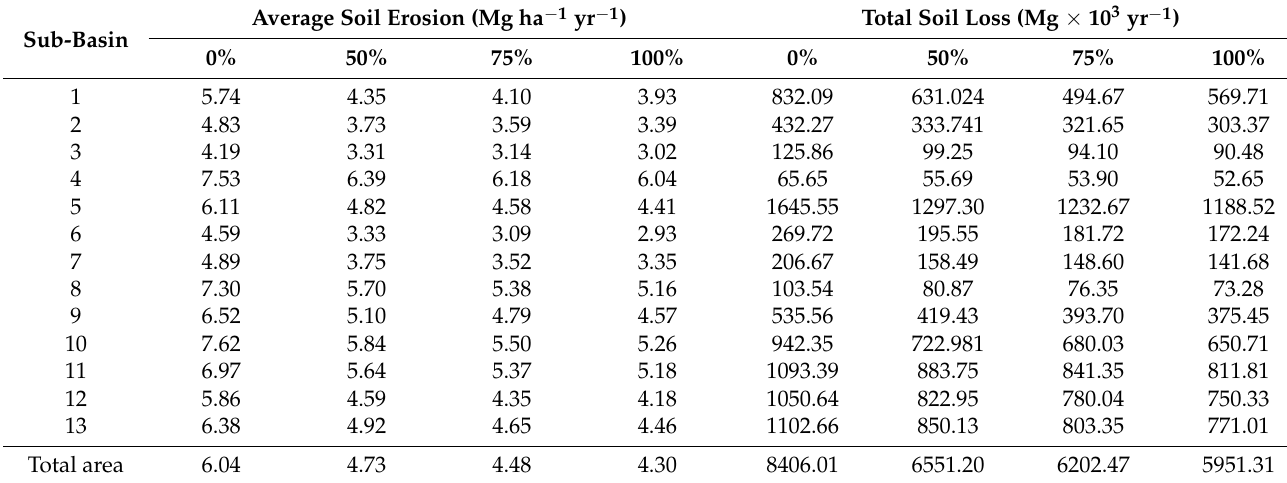
Table 6. Average soil erosion and total soil loss per